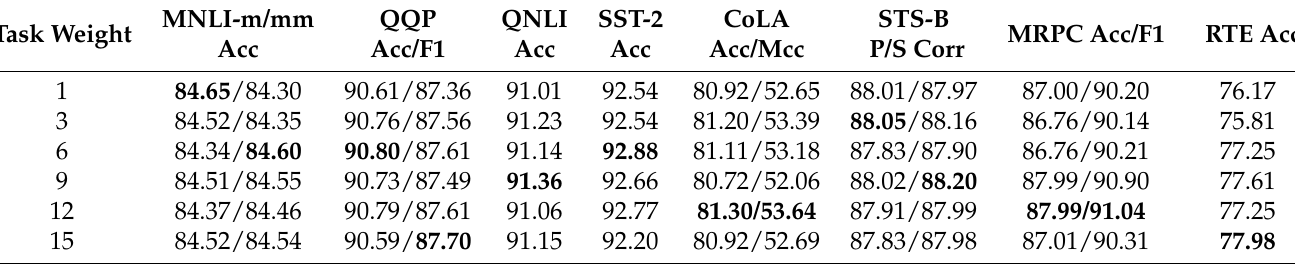
Table 2. Validation performance of MTDNN-SIWLM are reported; highest results are in bold font. Task Weight